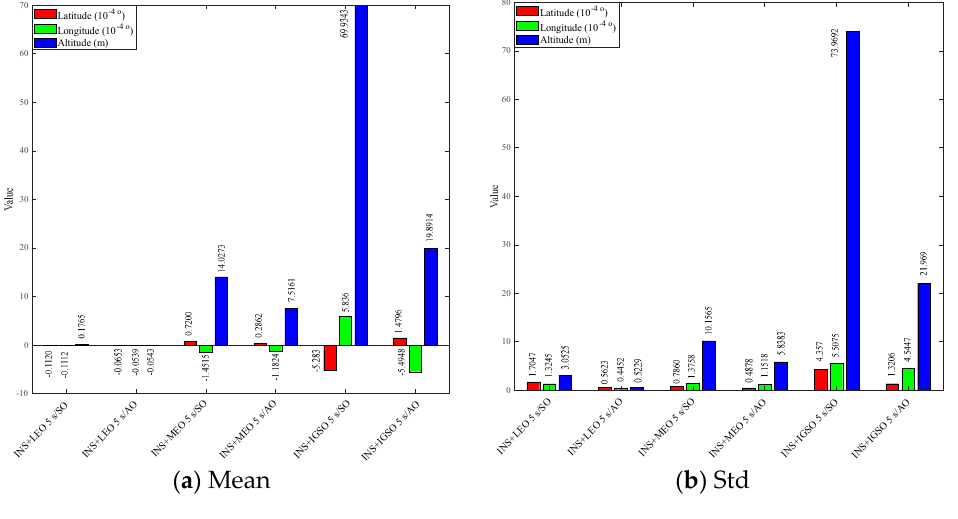
Figure 9. Error statistics.